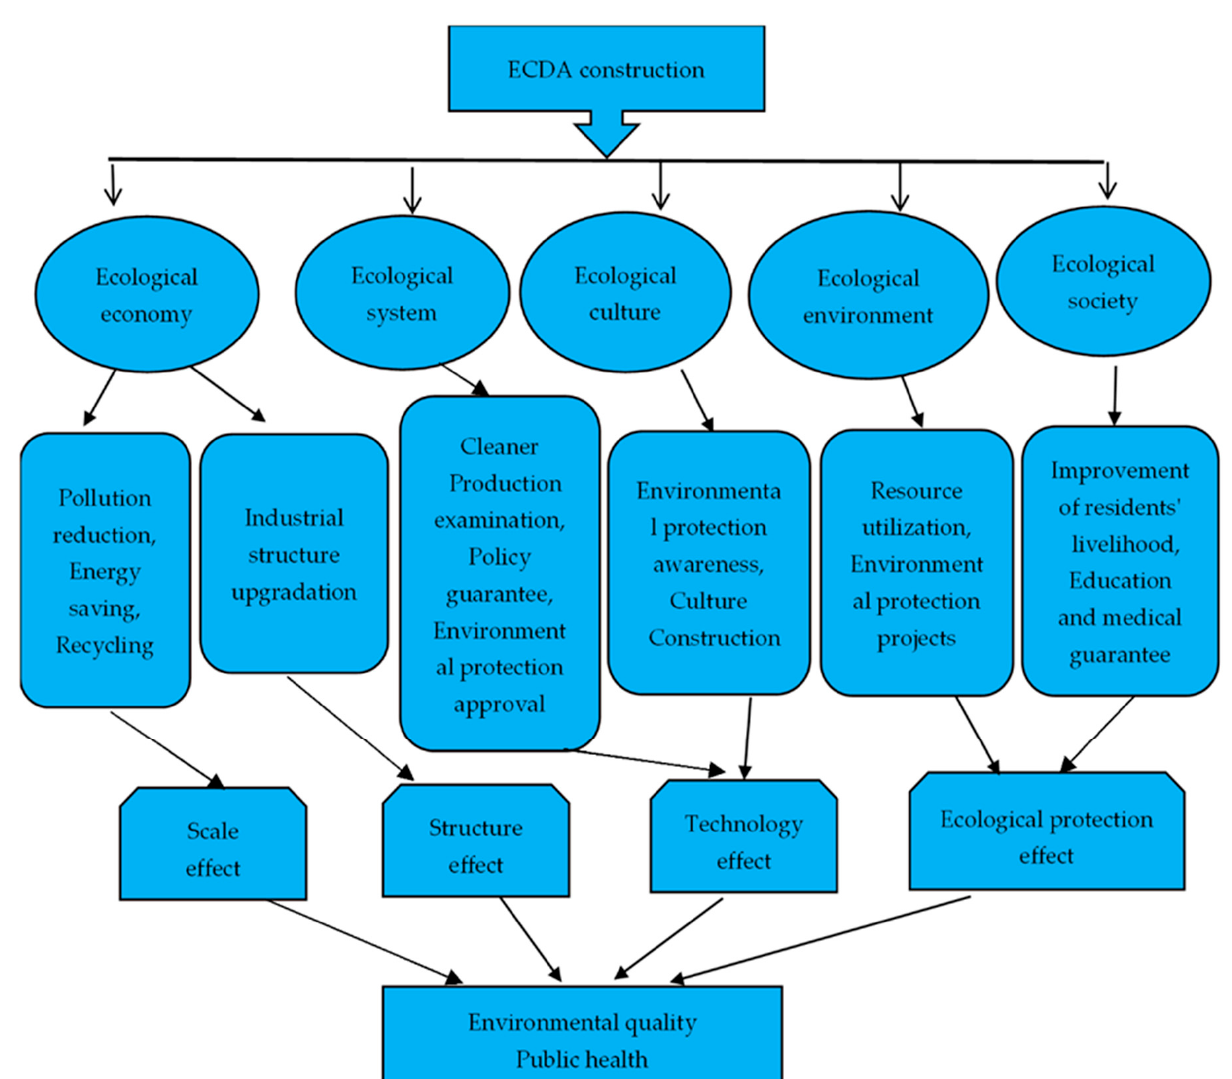
Figure 3. Theoretical framework.